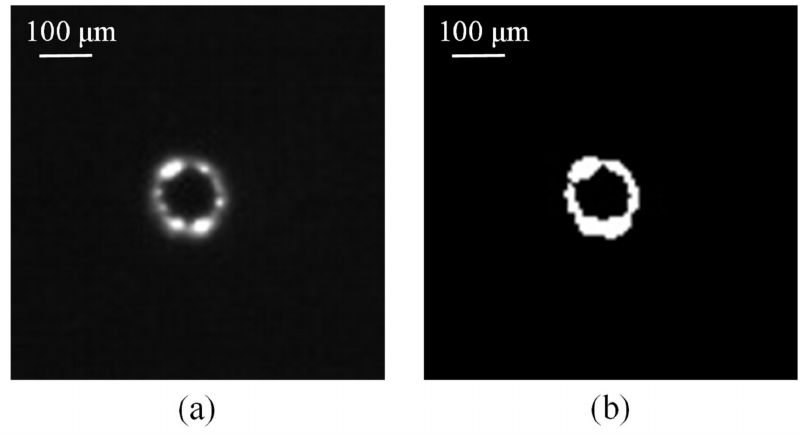
Figure 6. The arcing plasma area of an image of quartz glass in the coaxial direction ( a ) acquired by an industrial camera and ( b ) after the thresholding technique.